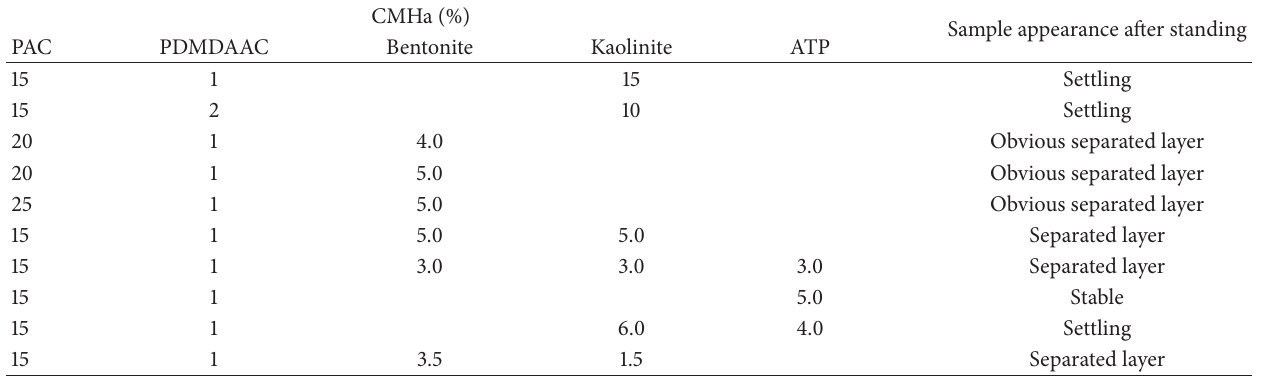
Table 1: The stability of different kinds of minerals in the CMHa.